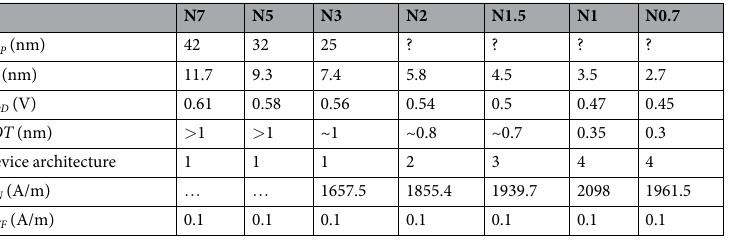
Table 2. Technology/device/circuit level parameters for high performance logic roadmap, and monolayer black phosphorus device architectures: (1) Double gate + High-k dielectric with IL, (2) Double gate + High-k dielectric with IL + Underlap, (3) Double gate + High-k dielectric with IL + extended BG + UL/JL, (4) Double gate + thinner 2D high-k oxide + extended BG + UL/JL. Here, ON current ( I ON ) includes the effect of contact resistance and